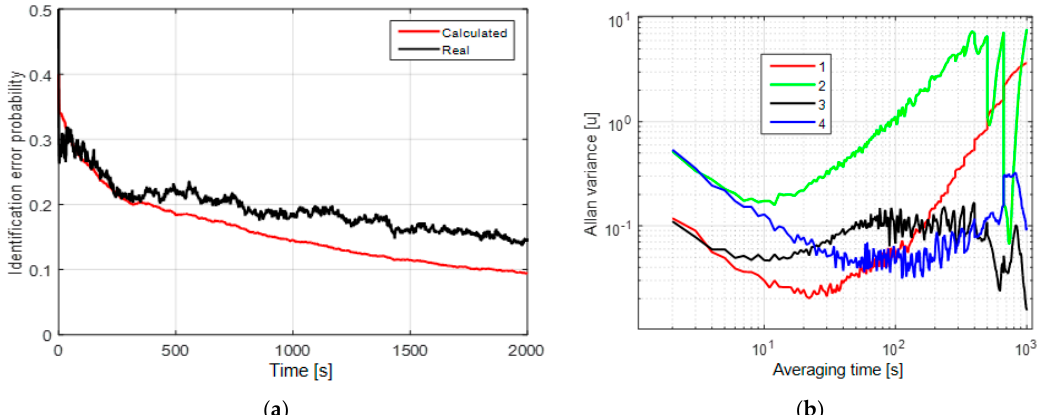
Figure 3. ( a ) Unconditional probability of the identification error with the white-noise component of RMS σ 1,2 v ∈ [ 0.25 1 ] u; ( b ) Allan variances for the sums of white noises and the random walk with = 0.04 u, σ = 0.5 u (1—red), σ = 0.15 u, σ = 1 u (2—green) and with the first-order Markovian σ w v w v process with τ = 1 min, σ m = 0.5 u, σ v = 0.5 u (3—black), τ = 25 min, σ m = 1.5 u, σ v = 1 u